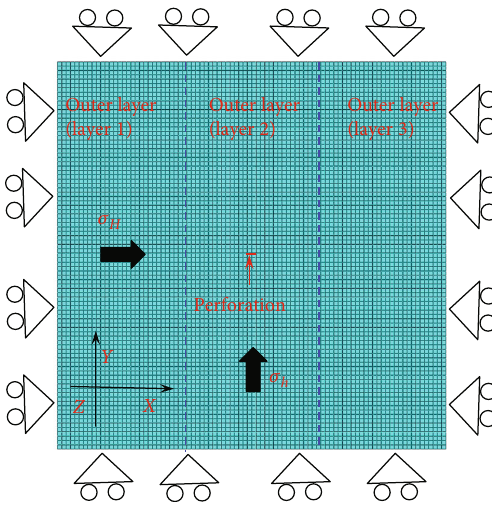
Figure 3: Graphical representation of simulation model with single